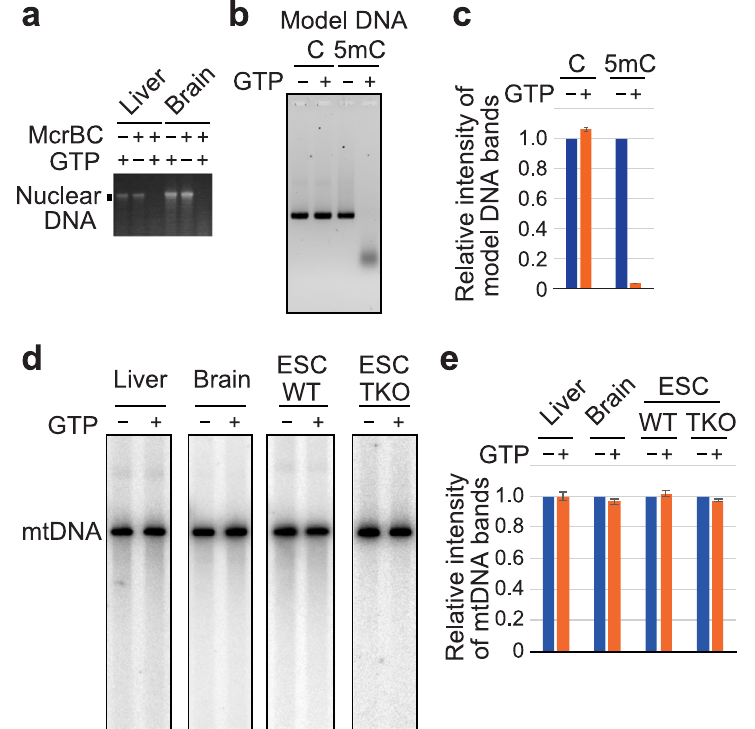
Figure 4. Analysis of mtDNA with methylated cytosine-sensitive endonuclease McrBC. ( a ) Ethidium bromide staining image of nuclear DNA after agarose gel electrophoresis. Samples were total nucleic acid (total NA) from mouse liver and brain tissues incubated without ( − ) or with ( + ) McrBC and without ( − ) or with ( + ) GTP. The full-length gel is presented in Supplementary Fig. S6a. ( b ) PCR-generated DNA fragments containing unmodified cytosines (C) or 5mC were treated with McrBC with or without GTP, and then were electrophoresed and visualised by Sybr Green I staining. ( c ) Quantification of the full-length band region in ( b ). Intensities of bands in − GTP lanes were expressed as 1 and the relative intensities of corresponding + GTP lanes were calculated for each experiment. Assays were performed three times and means are shown with SEM. ( d ) Southern hybridisation images of linearised mtDNA of liver, brain, wild-type ESCs (WT) and TKO ESCs (TKO) treated with McrBC in the absence or presence of GTP. Blot images with cropped regions which are necessary to be shown in this study are presented in Supplementary Fig. S6b. ( e ) Band intensities of full- length mtDNA ( − GTP) were expressed as 1 and the relative intensity values of bands with McrBC cleavage ( + GTP) were calculated for each experiment for each sample. Two independent preparations of samples were analysed for three times (technical triplicates) and the average of technical triplicates was given for each sample. Subsequently, means were calculated from the two average values and are presented in the graph with errors of the